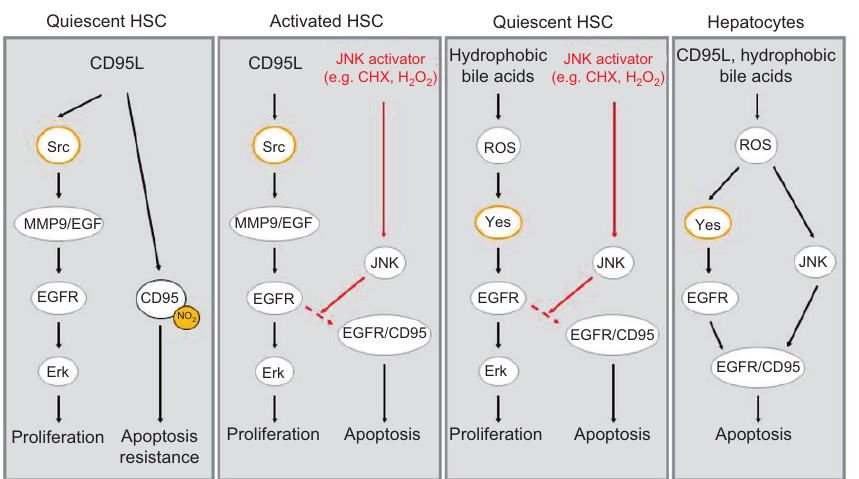
Figure 3 Signaling of Src family kinases toward proliferation and apoptosis in HSCs and hepatocytes. Hydrophobic bile acids and CD95L are potent inducers of apoptosis by triggering a Yes-dependent activation of the EGFR and subsequent activation of CD95 in liver parenchymal cells (hepatocytes). In quiescent HSC, CD95L does not induce apoptotic cell death but stimulates HSC proliferation via a c-Src-dependent shedding of EGF and ligand-dependent activation of the EGFR. Simultaneously, CD95L triggers an inactivating CD95 tyrosine nitration. Like in quiescent HSC, CD95L induces a c-Src- and ligand-dependent EGFR activation, but no inacti- vating CD95-tyrosine nitration occurs in activated HSC. As a result, proliferation is stimulated unless a JNK signal comes into play, which triggers CD95/EGFR association and apoptosis induction. Hydrophobic bile acids trigger a rapid formation of ROS and Yes-dependent